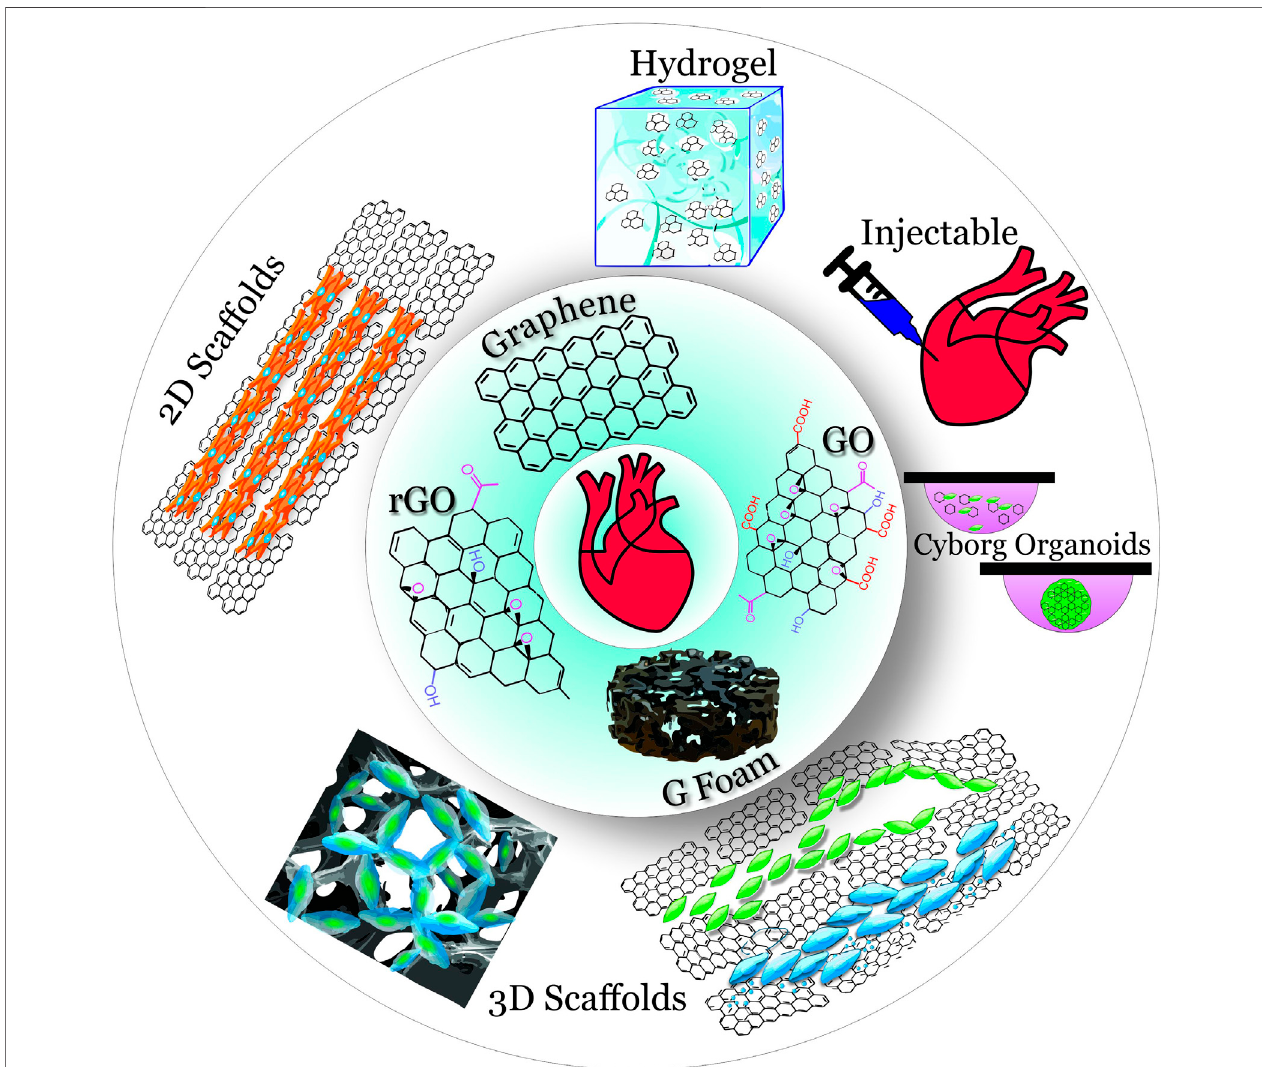
FIGURE 1 | Overview of graphene materials (inner circle) used in 2D and 3D scaffolds (outer circle) for cardiac tissue engineering.